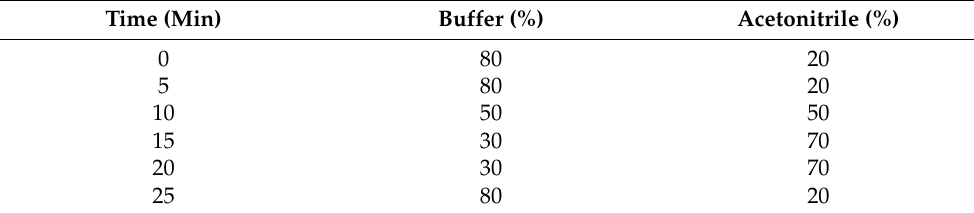
Table 1. Gradient elution